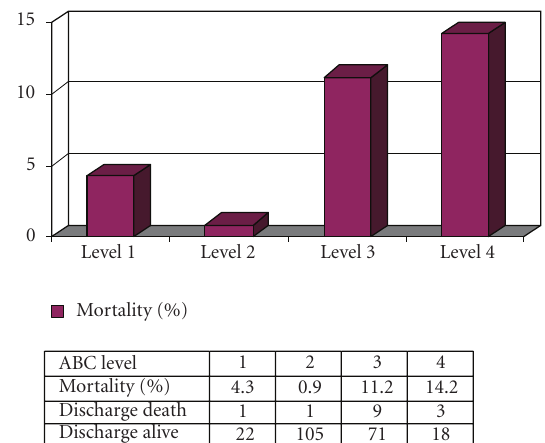
Figure 3: Mortality rate by ABC level in the present study ( n =